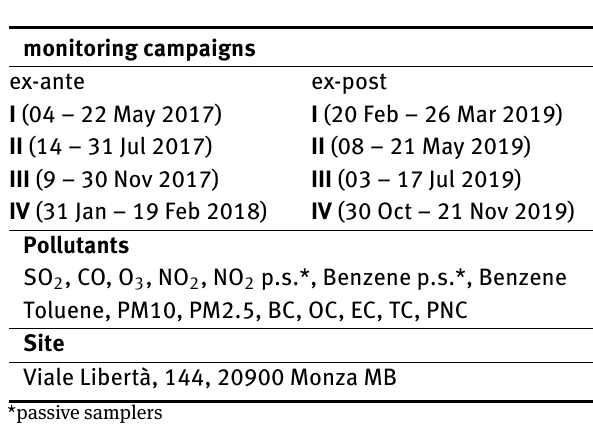
Table 1: Ex-ante/ex-post monitoring campaigns, sites and